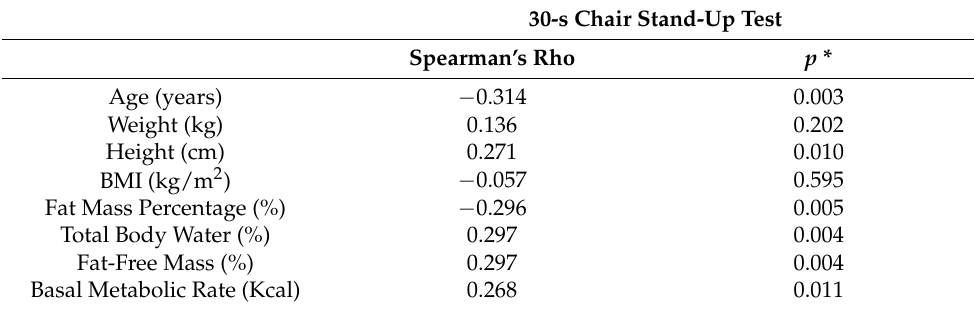
Table 1. Correlations between the 30-s chair stand-up test and the anthropometric data in type 2 diabetes mellitus people ( n =